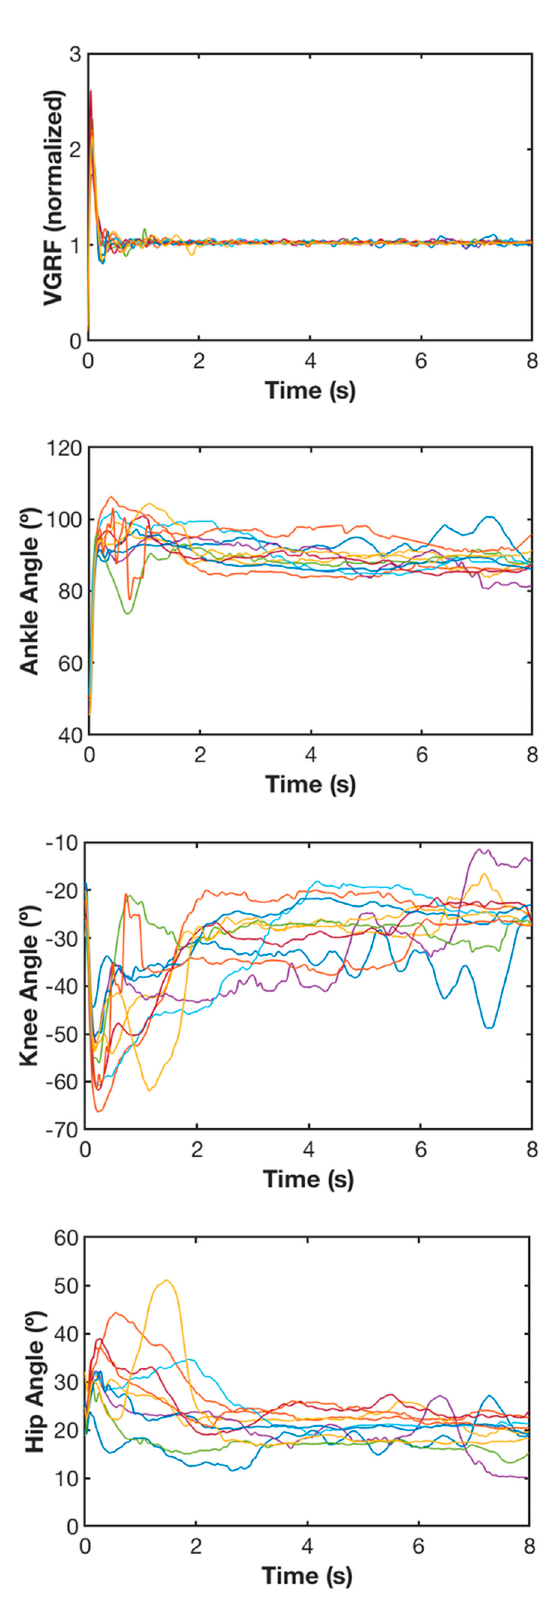
Figure 1. Example of a participant’s vertical ground reaction force (VGRF) normalized according to the body weight; and ankle, knee and hip angles in the sagittal plane expressed in degrees for the 10 trials. Each color line represents a trial.